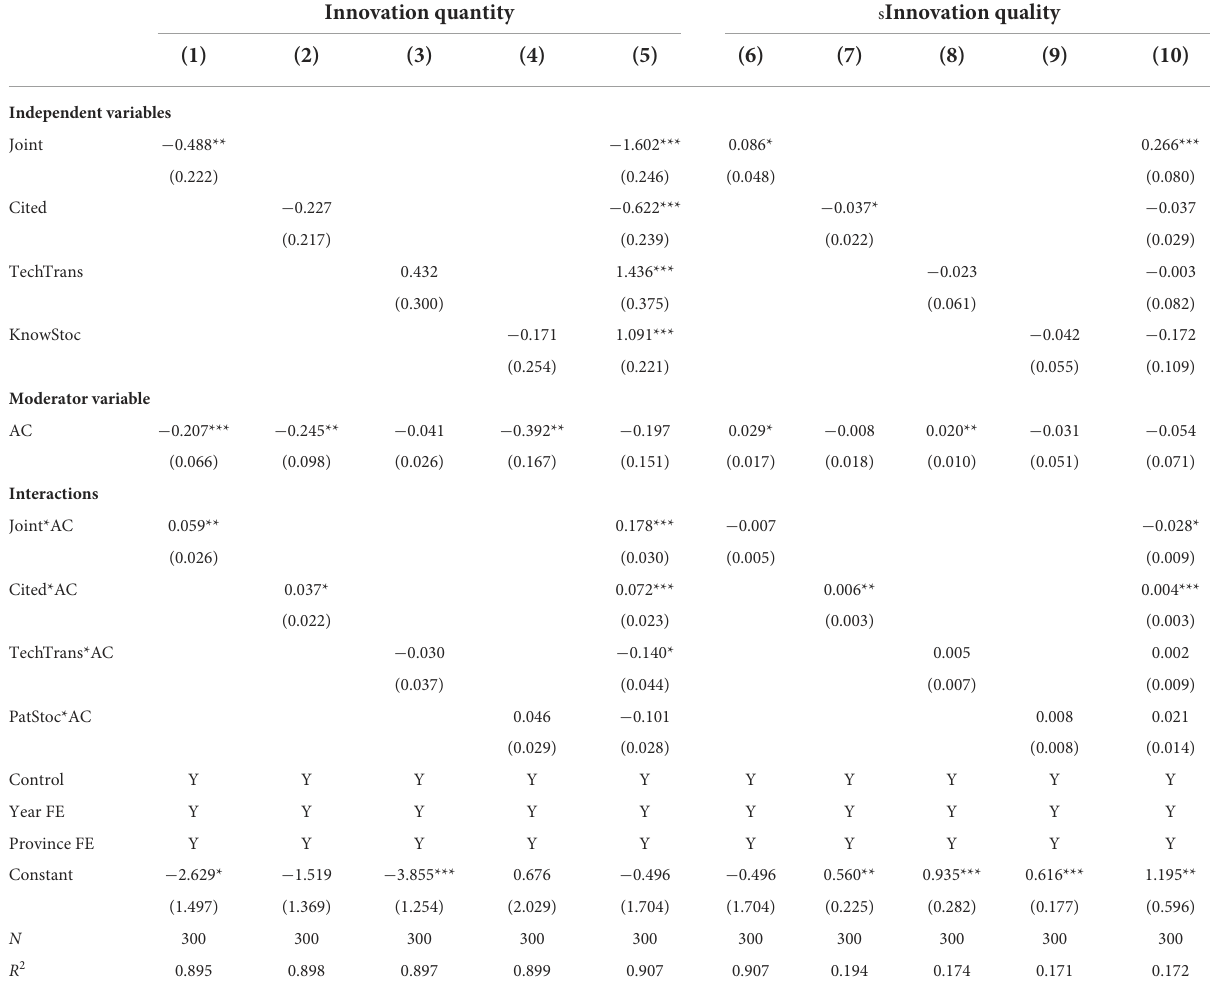
TABLE 4 The moderating effect of firm absorptive capacity. Innovation quantity s Innovation